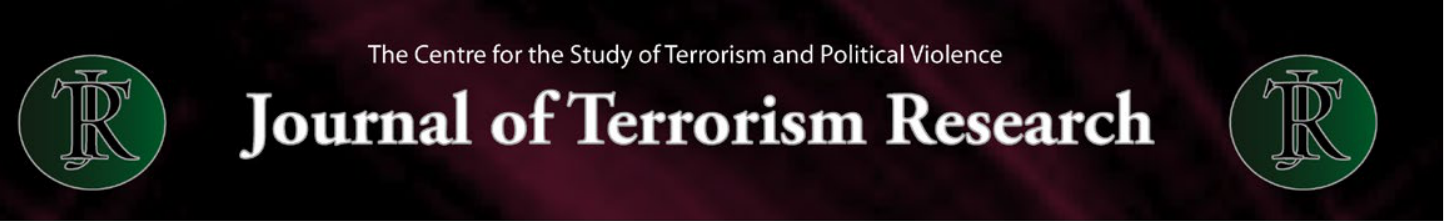
Figure 1: Example of privilege in IRC chat (the highlighted